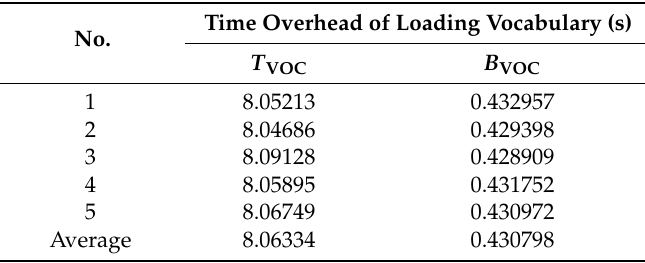
Table 2. Time overhead comparison of loading two kinds of vocabularies.